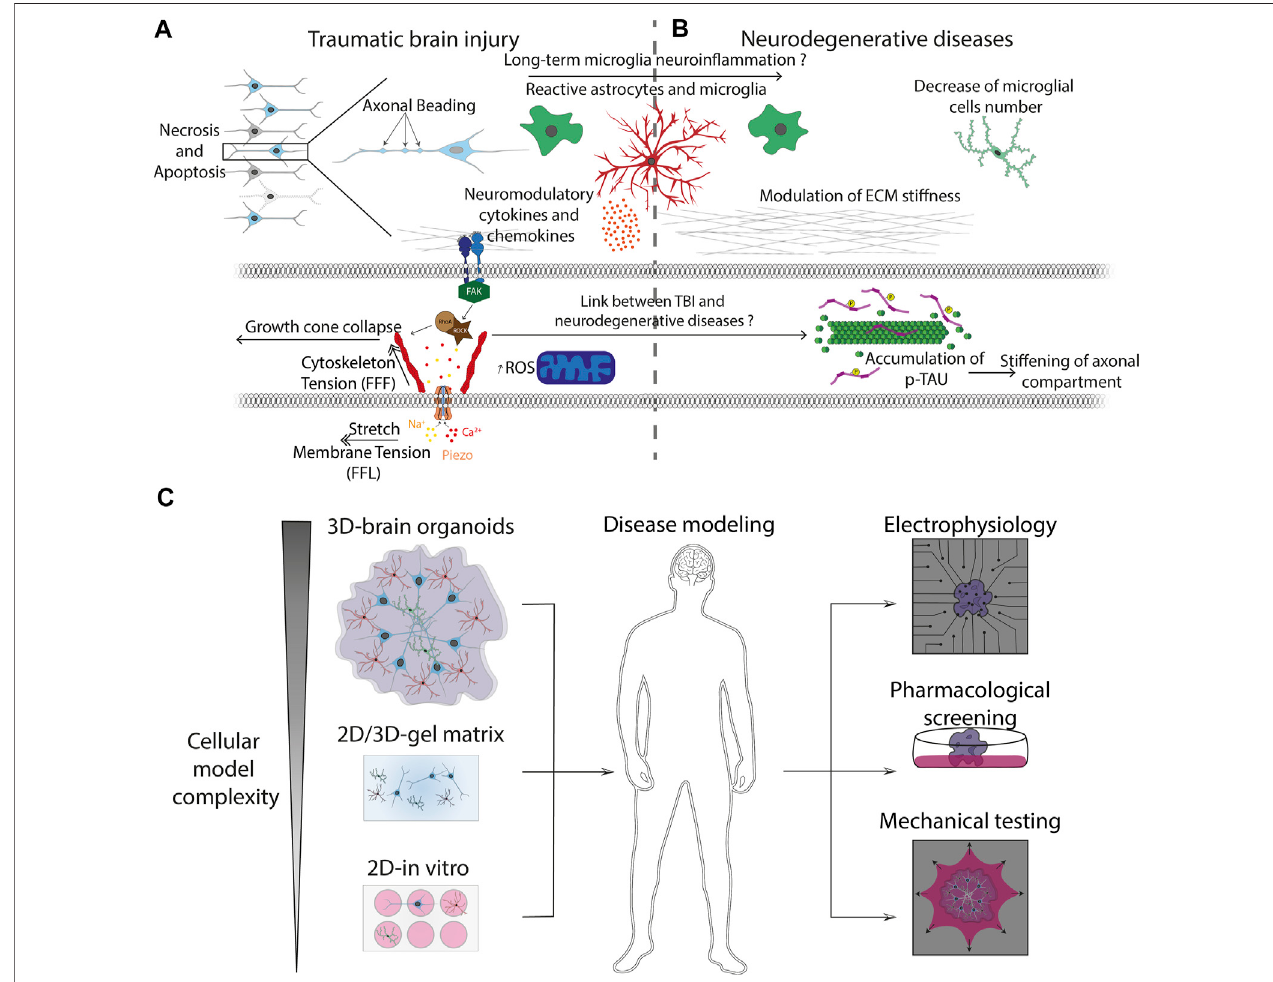
FIGURE4| Pathophysiologicalprocessesandadvanced invitro models (A) Mechanically-induceddiseases,suchasTBI,leadstoaxonalbeadingandactivationof glial cells. Reactive astrocytes and microglia trigger the release of cytokines and neuromodulatory chemokines that are involved into the long-term neuroin fl ammation process observed in neurodegenerative diseases. Injury forces applied to neuronal and glial cells are transmitted from the ECM to the cytoskeleton through transmembrane integrins. Focal adhesion kinase (FAK) is a cytoplasmic tyrosine kinase that plays critical roles in integrin-mediated signal transduction and can trigger the activation of the Rho-ROCK pathways, leading to rearrangement of actin fi laments and ultimately to the axonal growth cone collapse. (B) Cytoskeletal changesarerelatedtotheformationofproteinaggregatessuchasphosphorylatedtheneuronalmicrotubuleTauprotein,whichisahallmarkofmanyneurodegenerative diseases. This process can be followed by a stiffening of the axonal compartment and major modi fi cations of the ECM mechanical properties. (C) Advanced bioengineered systems allow to increase the complexity of conventional 2D culture models to obtain physiologically relevant 3D pluricellular models such as brain organoids. The 3D culture models can be combined with mechanical assays and new electrophysiological methods such as microelectrode arrays (MEA) for investigating brain development, neurodegenerative diseases and to improve the screening of pharmacological drug candidates.